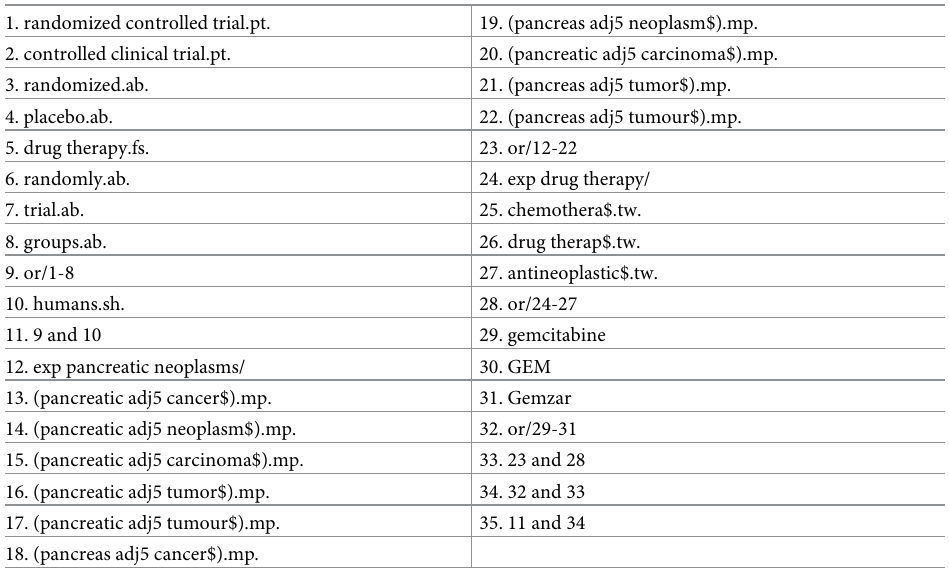
Table 1. Search strategy for MEDLINE (Ovid format) used in this meta-analysis. 1. randomized controlled